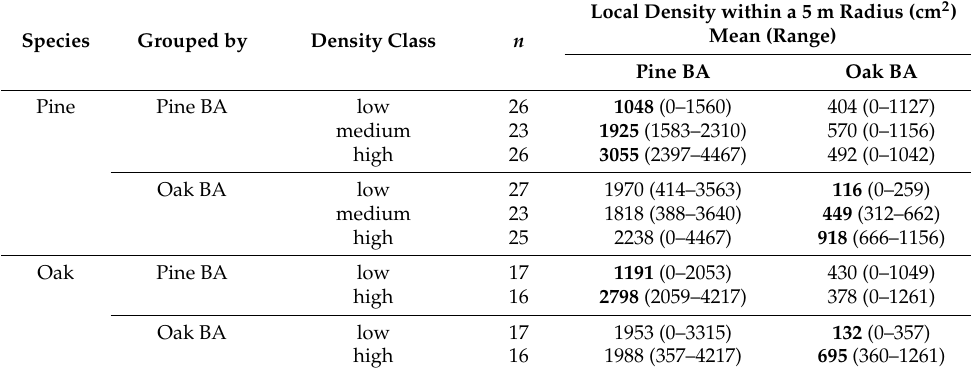
Table 2. Local density classes (low, medium, high) used to account for competition effects in the assessment of high-frequency climate responses. Mean local density (i.e., local stand basal area, BA) used as the grouping criteria for each class is highlighted in